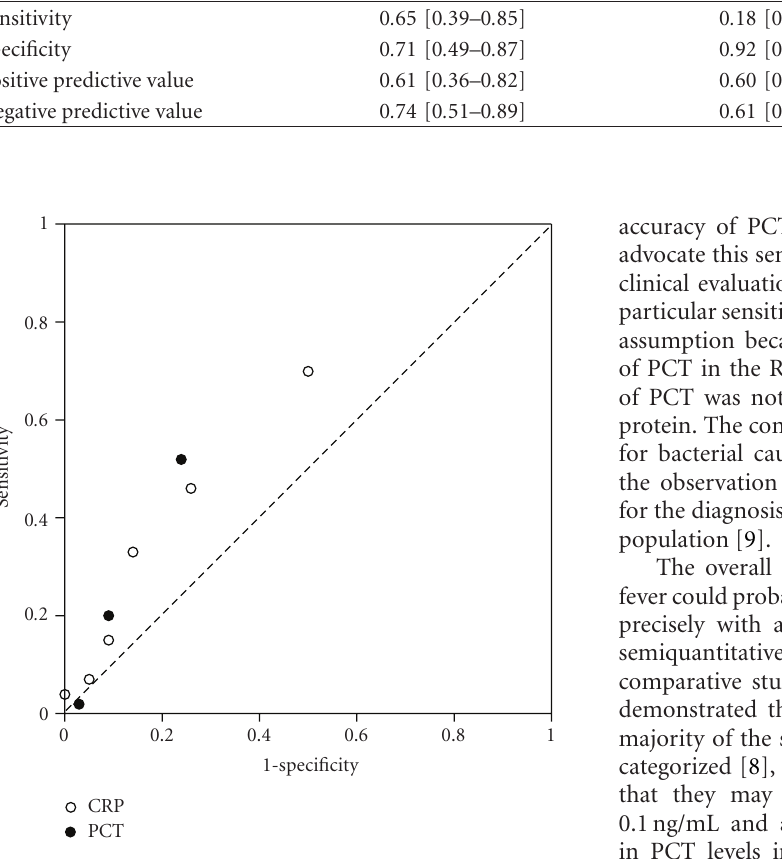
Figure 3: Receiver operating characteristic (ROC) curves of procalcitonin (PCT) and C-reactive protein (CRP) testing on admission for a confirmed bacterial cause of fever in 157 travellers who returned home with fever after a stay in the (sub)tropics. The respective cuto ff points for CRP were 300, 250, 150, 100, and 50mg/L, respectively, and the cuto ff points for PCT were 10, 2, and 0.5ng/mL,